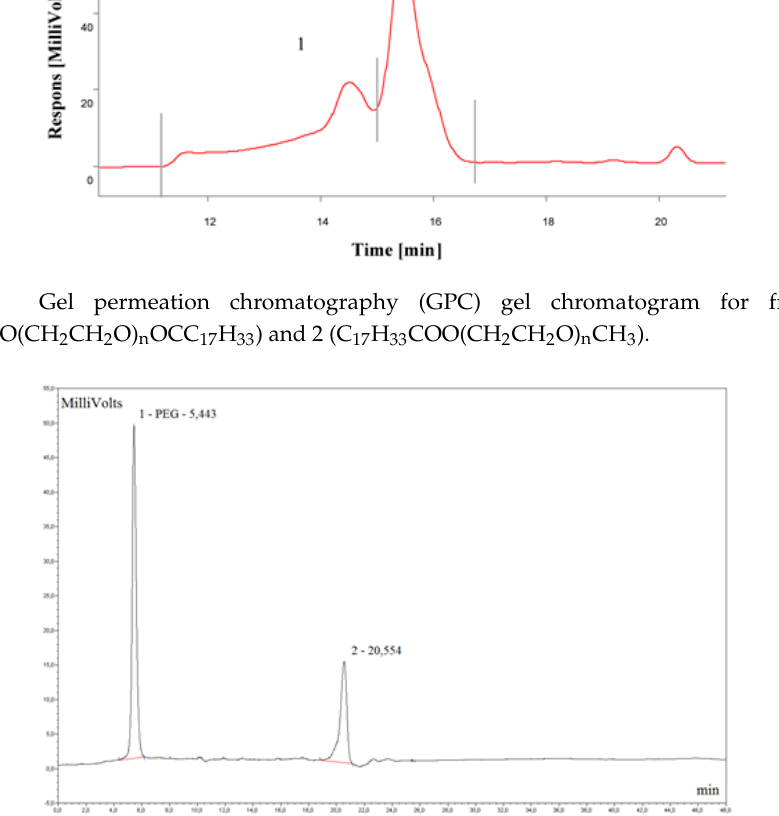
Figure 3. High performance chromatography (HPLC) chromatogram, where the higher peak represents fraction 2 (C 17 H 33 COO(CH 2 CH 2 O) n CH 3 ) and the smaller peak represents fraction 1 ( C 17 H 33 COO(CH2CH2O) n OCC 17 H 33 ).